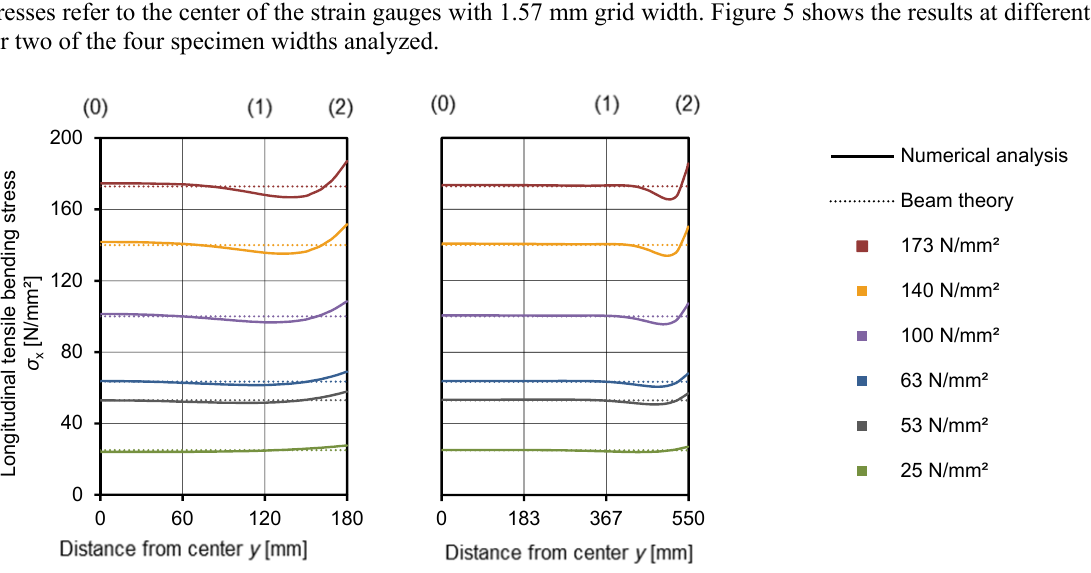
Fig. 5 Longitudinal tensile stresses across the specimen width along the transverse axis at bending stresses σ bth between 25 and 173 N/mm 2 . Left: B = 360 mm, right: B = 1100 mm. Glass thickness h = 3.2 mm, Young’s modulus E = 70 · 10 3 N/mm 2 , Poisson's ratio ν =